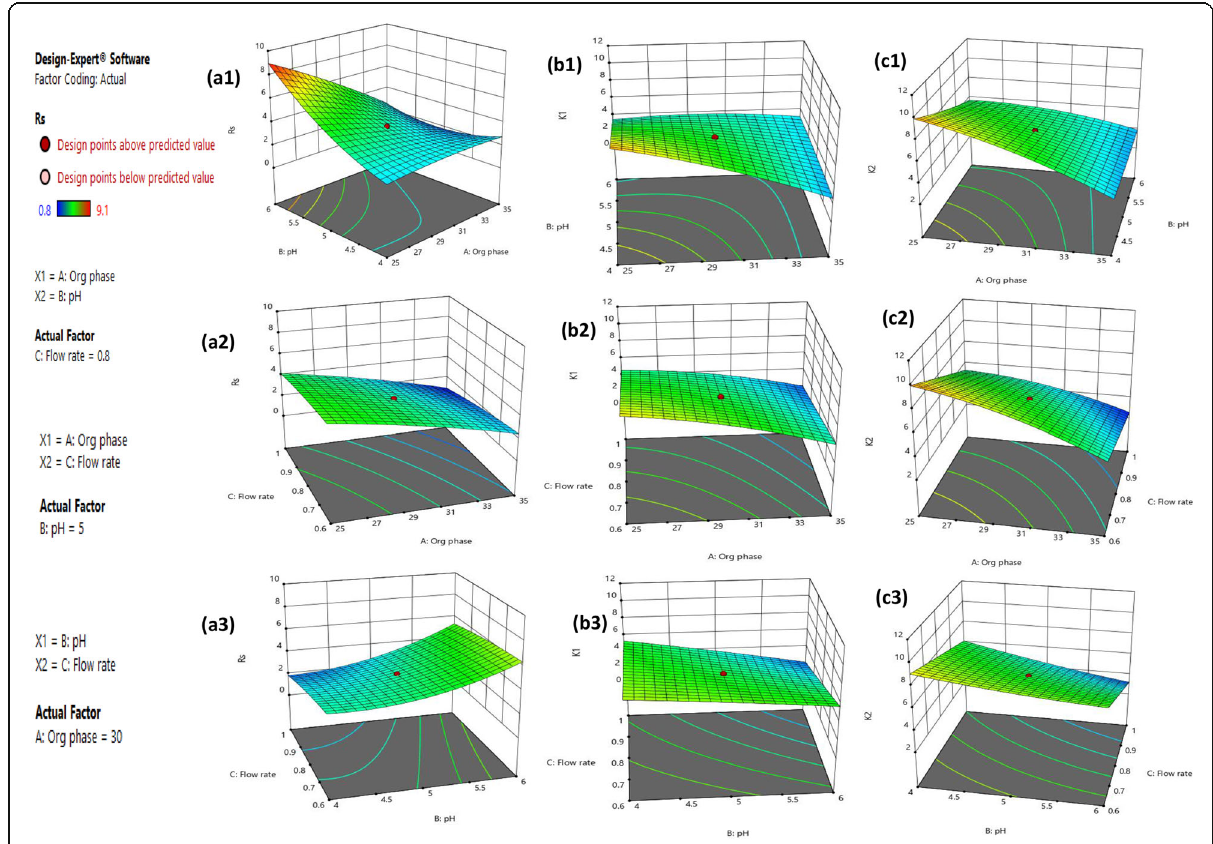
Fig. 1 Response surface plots of two variable interactions — ( a ) resolution; ( b ) dapagliflozin capacity factor; ( c ) saxagliptin capacity